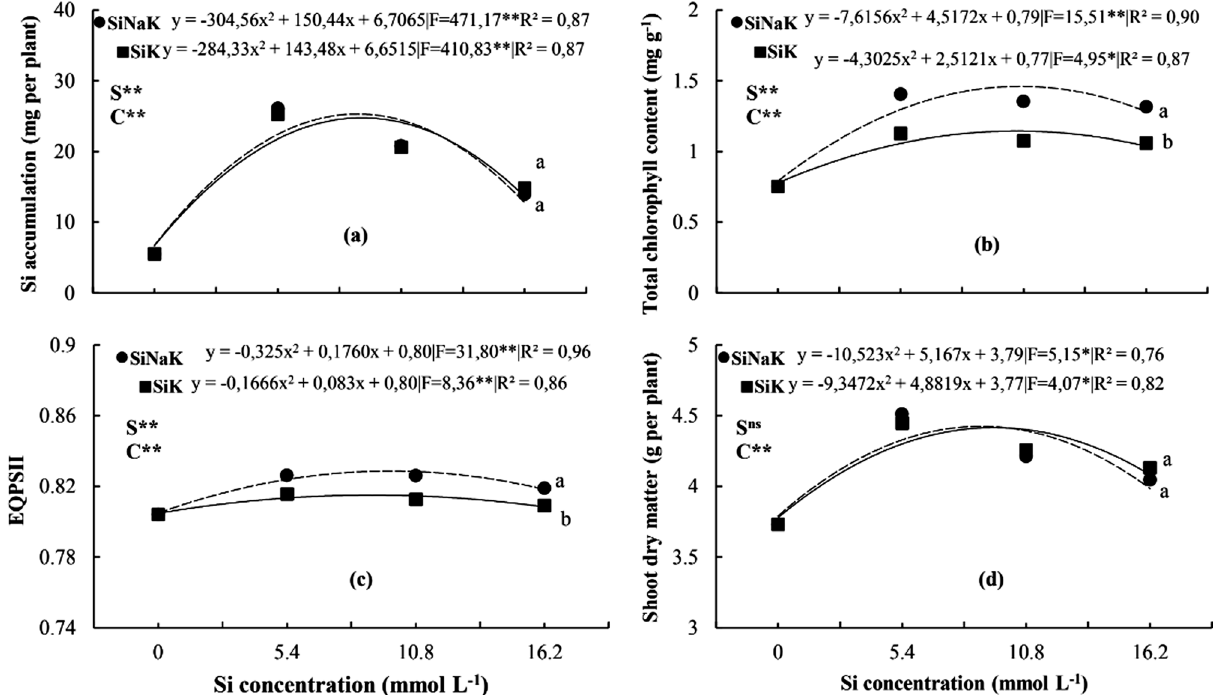
Figure 1. Si accumulation (shoot) ( a ), total chlorophyll content ( b ), QEPII—Quantum efficiency of photosystem II ( c ) and shoot dry matter ( d ) of bean plants cultivated with different sources (S) of Si [sodium and potassium silicate stabilized (SiNaK) and potassium silicate without stabilizer (SiK)] and increasing concentrations (C) of leaf-applied Si.**Significant at 1% probability; ns no significant at 5% probability; Different letters in the same Si concentration indicate differences (P < 0.05, Tukey test) between